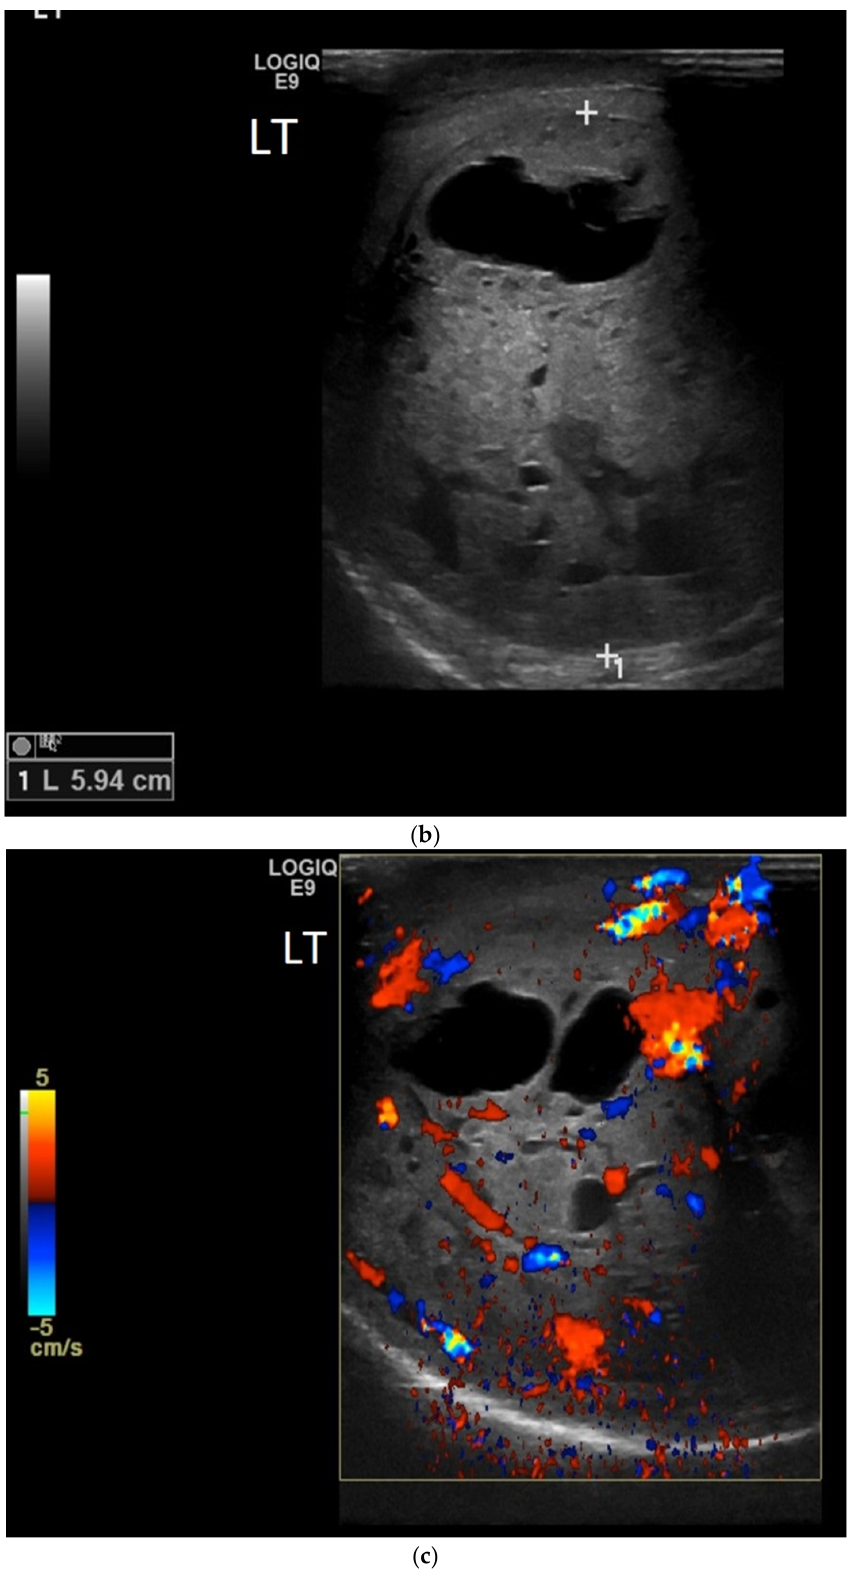
Figure 5. ( a , b ) B-mode ultrasound demonstrates thickened scrotal skin and a 5.9cm lesion with cystic and solid components in a patient following trauma. ( c ) Colour Doppler shows increased vascularity within the solid components. Subsequent orchidectomy confirmed a teratoma, which presented following